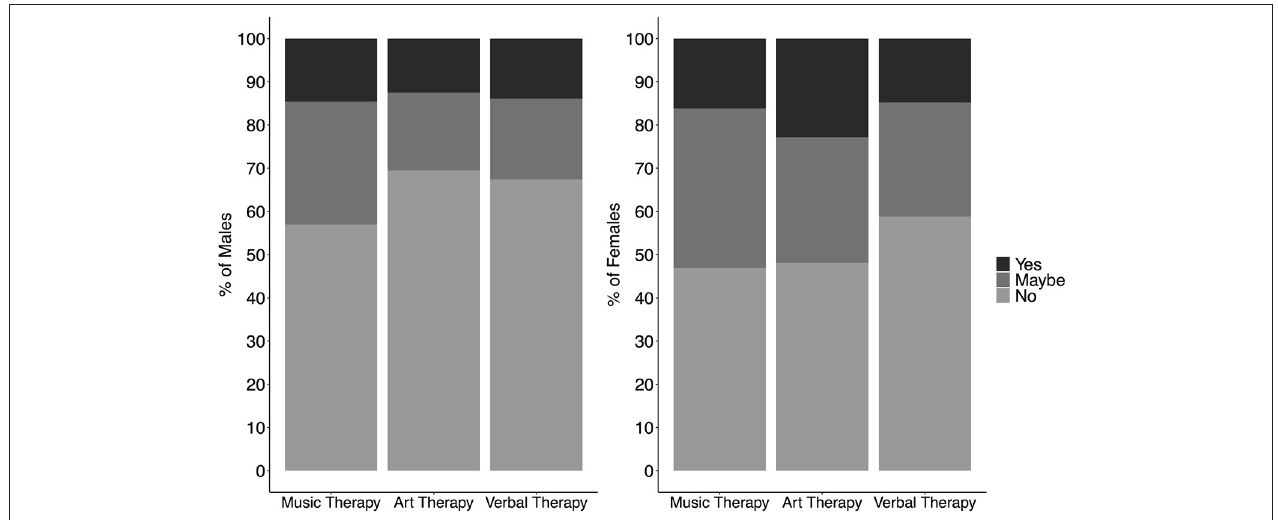
FIGURE 5 | Percentage of males ( n = 144; left panel) and females ( n = 634; right panel) indicating if they were interested, maybe interested, or not interested in three types of drop-in online therapy: music, art, and verbal. Note that out of students with gender other than male or female ( n = 4), 1 said No to Music Therapy, 3 said Yes to Music Therapy, 1 said No to Art Therapy, 3 said Yes to Art Therapy, 3 said No to Verbal Therapy, and 1 said Yes to Verbal Therapy).